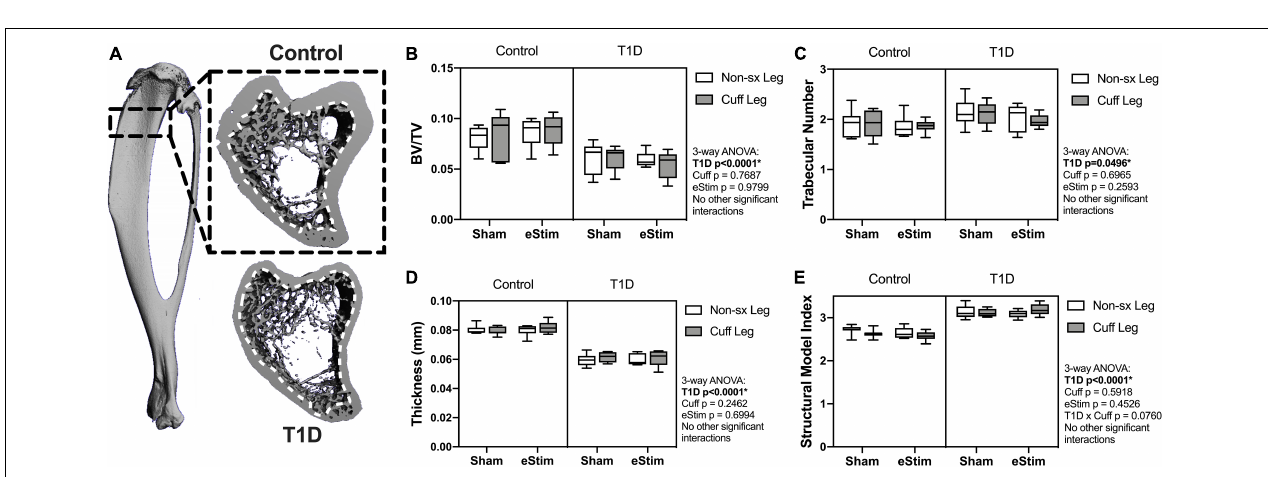
FIGURE 6 | Cancellous bone. Cancellous bone was analyzed 2 mm below the growth plate in a 1.5 mm region (A) , dotted line represents contour inside of which bone was analyzed. (B) Cancellous bone volume fraction (BV/TV). (C) Trabecular number. (D) Trabecular thickness. (E) Structural model index (SMI). Control, sham n = 7; Control, eStim n = 6; Diabetic, sham n = 8; Diabetic, eStim n = 5; three-way ANOVA with repeated measures (Non-sx Leg vs. Cuff Leg); * p <